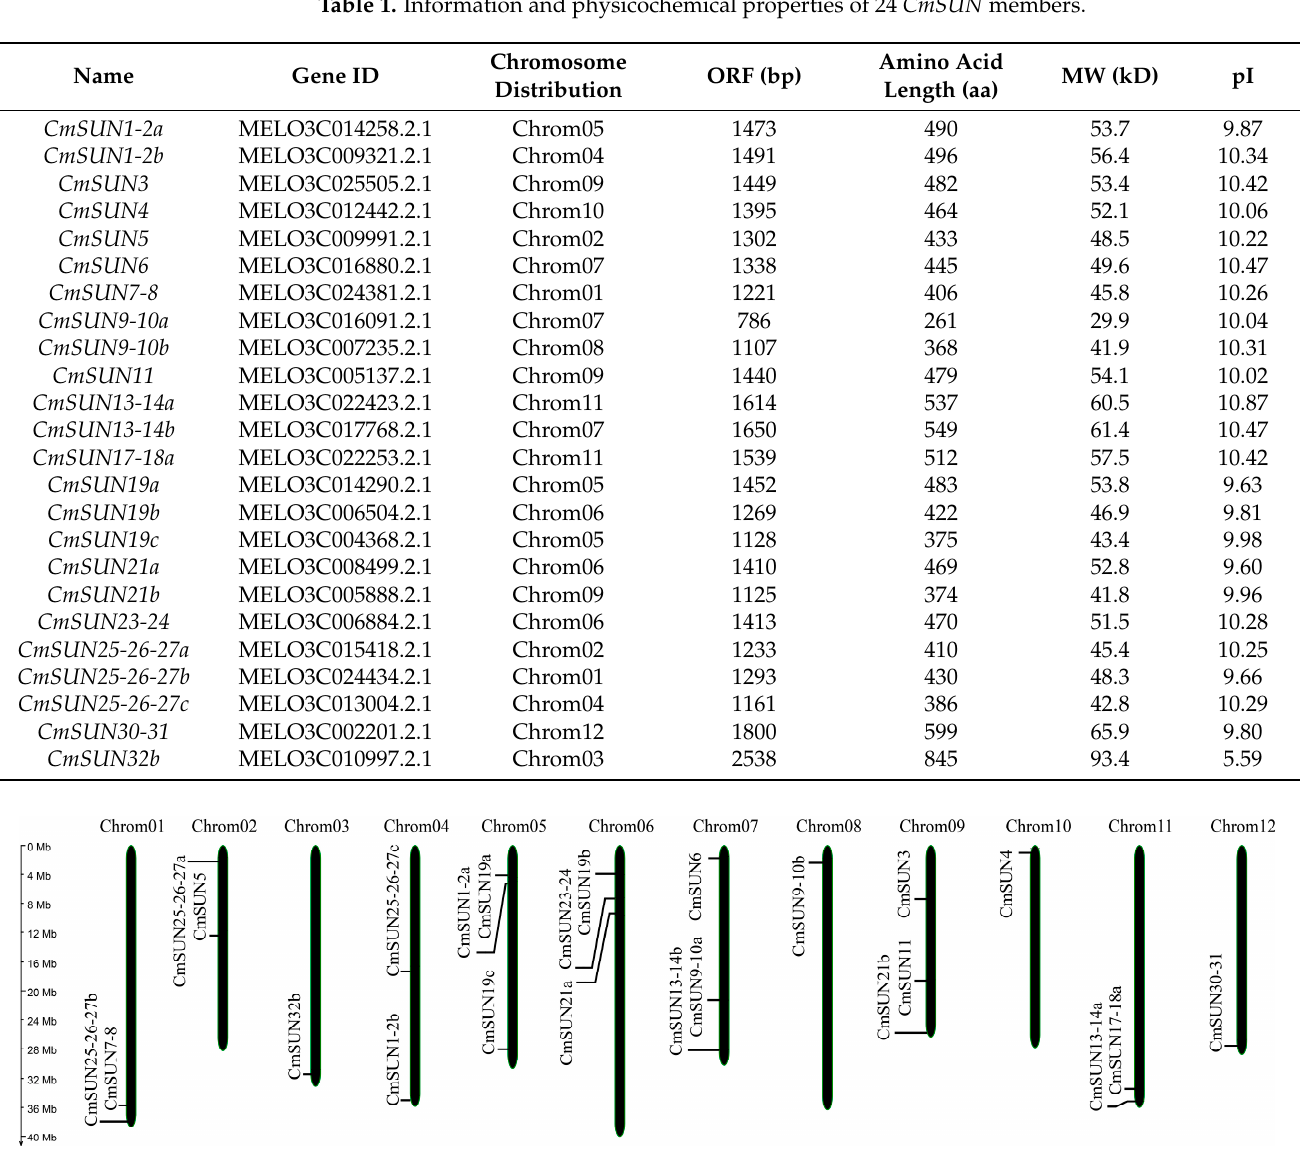
Figure 1. Distribution of 24 CmSUN genes on melon chromosomes. Through analyzing the CmSUNs protein domains, we found that arginine